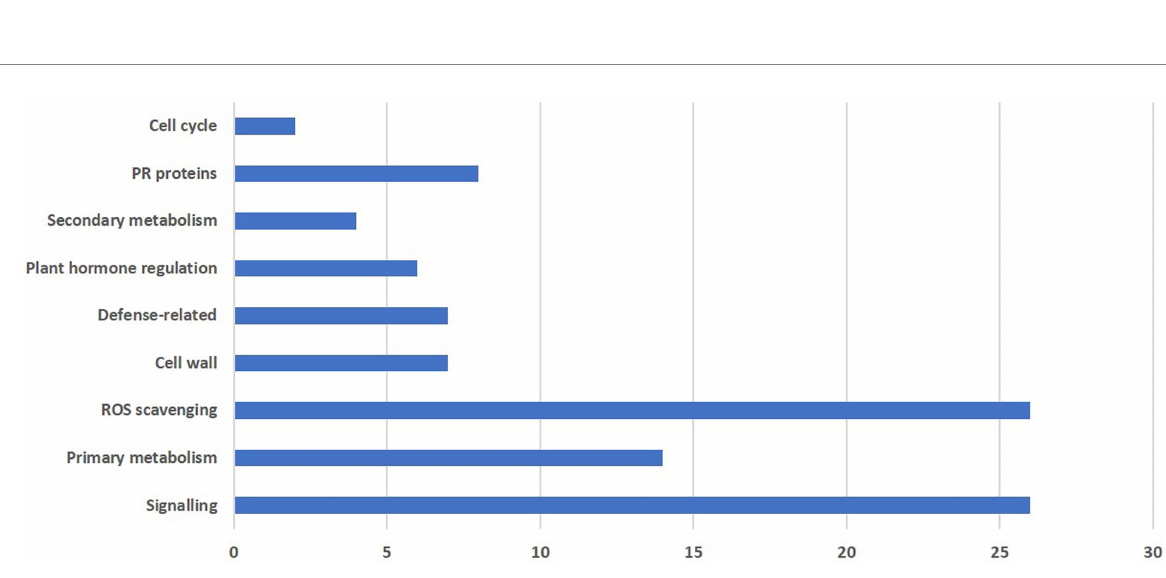
FIGURE 4 Functional grouping of total differentially expressed genes obtained from RNA-seq reads during M. grisea infection in pearl millet inbred ICMB